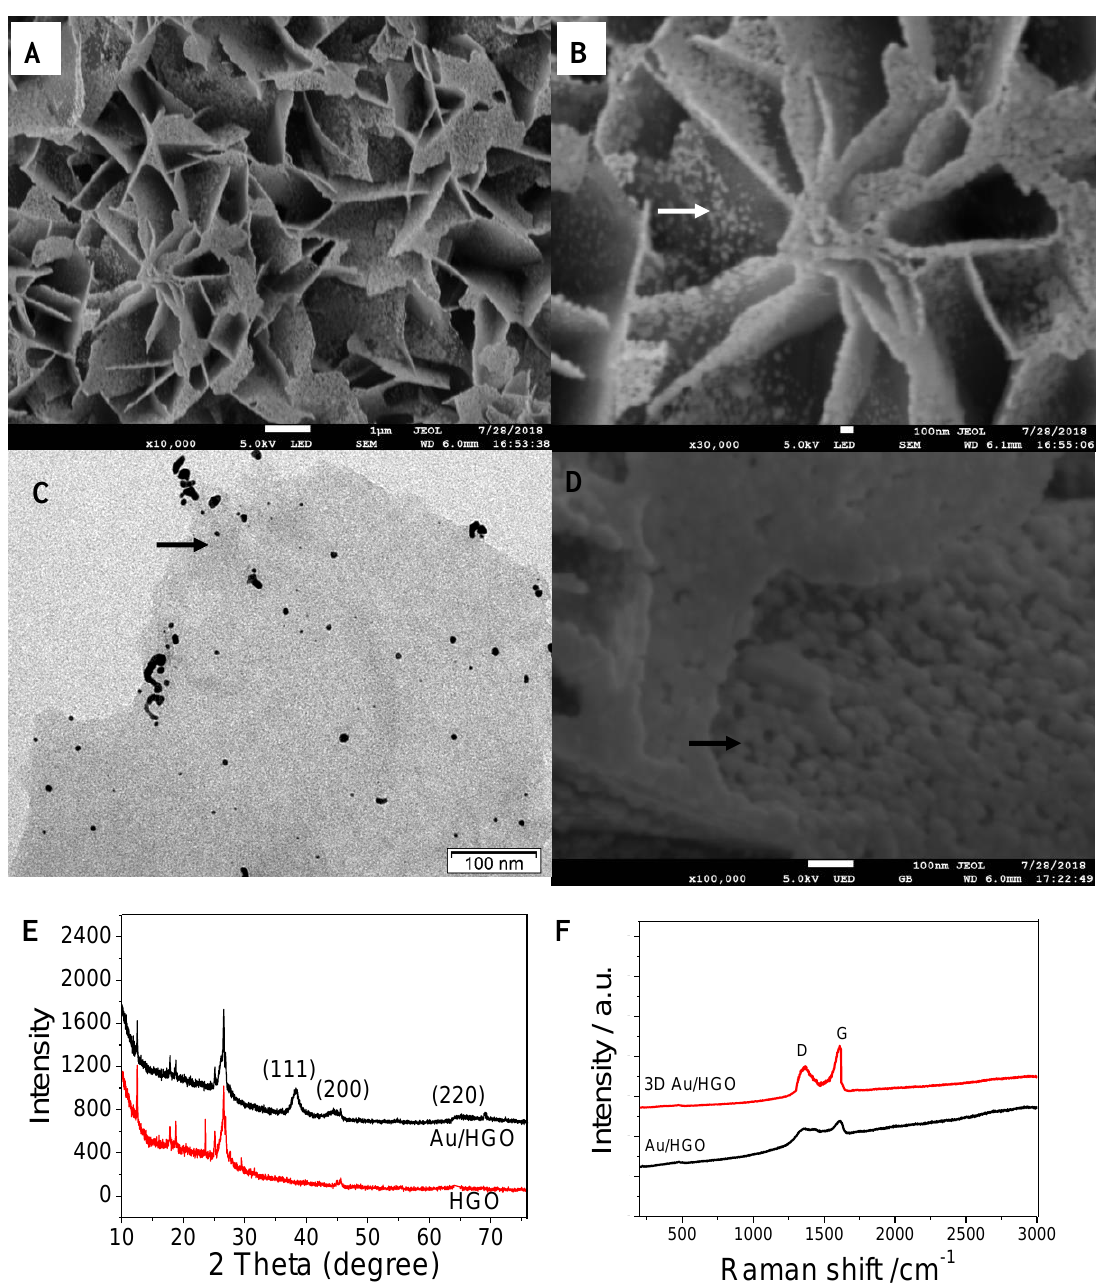
Figure 1. ( A ) Low- and ( B ) high-magnification SEM images of as-prepared 3DAu/HGO. ( C ) TEM and ( D ) SEM of Au/HGO. ( E ) X-ray diffraction (XRD) patterns and ( F ) Raman spectrum of 3DAu/HGO and holey-graphene oxide (HGO). Arrows indicate gold nanoparticles.